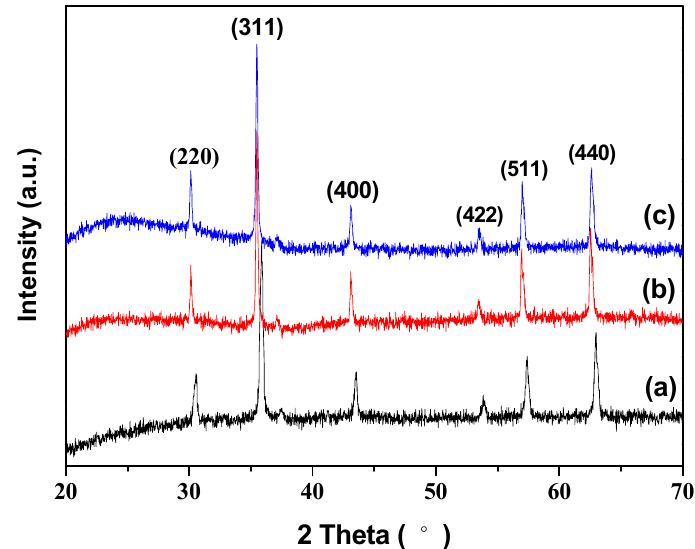
Figure 2. XRD patterns of (a) Fe 3 O 4 nanoparticles, (b) Fe 3 O 4 /SiO 2 core-shell composite nanospheres, and (c) Fe 3 O 4 /SiO 2 /PPy core-shell composite nanospheres.